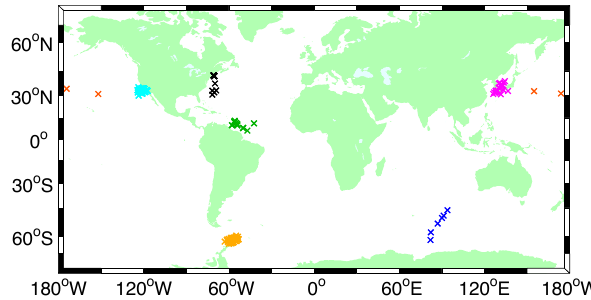
Figure 2. Map of stations with locations of the 244 in situ mea- surements used to develop the k d ( bg ) parameterization with CDM, Eq. (5), color coded by arbitrarily grouped by region: (1) western Atlantic, northern cluster in black; (2) western Atlantic, Amazon river outflow and offshore stations in green; (3) Antarctic peninsula in orange; (4) Southern Ocean in blue; (5) western Pacific in ma- genta; (6) stations across the Pacific Ocean in red and (7) eastern Pacific in cyan.